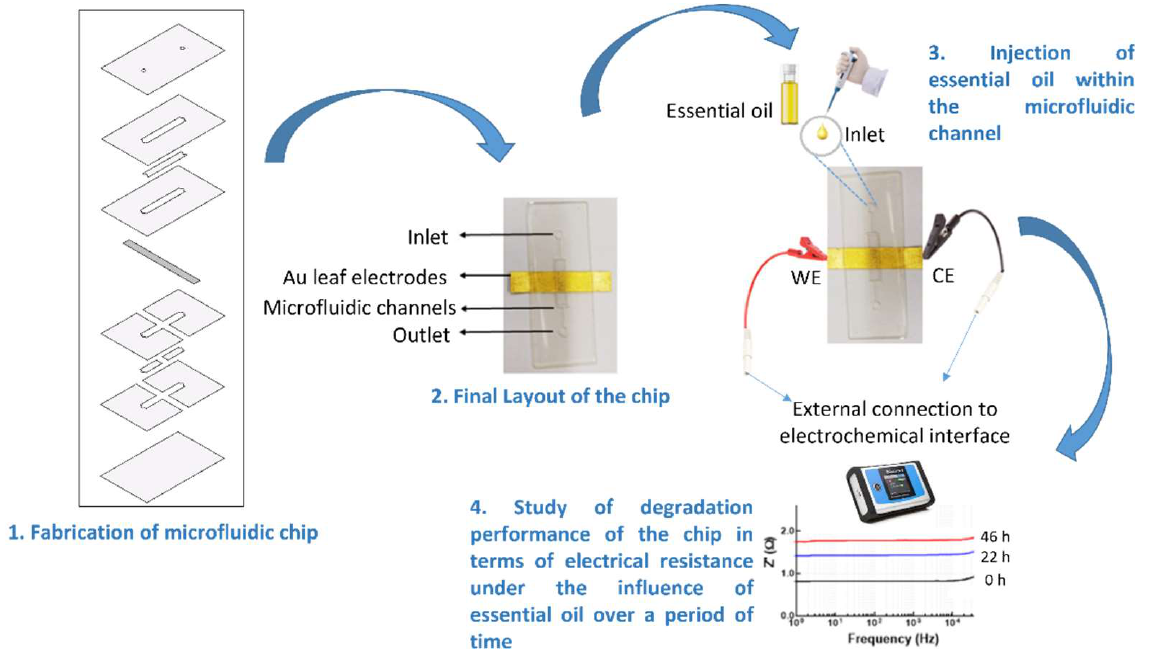
Figure 1. Exploded view of multi-layered Au leaf-based microfluidic chip design and layout of the study performed to analyze the electrical performance of the fabricated device under the influence of essential oil using impedance measurements. Table 1. Operating parameters of cutter plotter and hot laminator.